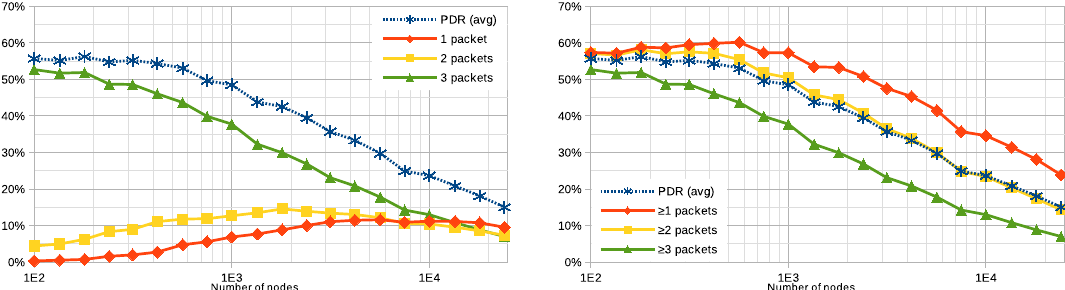
Figure 4. PDR and ratio of user nodes successfully communicating, in a function of the number of user nodes. The left graph plots the percentage of user nodes from which one, two, and three packets have been received. The right graph plots the number of user nodes from which ≥ 1, ≥ 2 and ≥ 3 packets have been received. Labels on the x -axes: 1E2 = 1 × 10 2 , 1E3 = 1 × 10 2 , 1E4 = 1 × 10 4